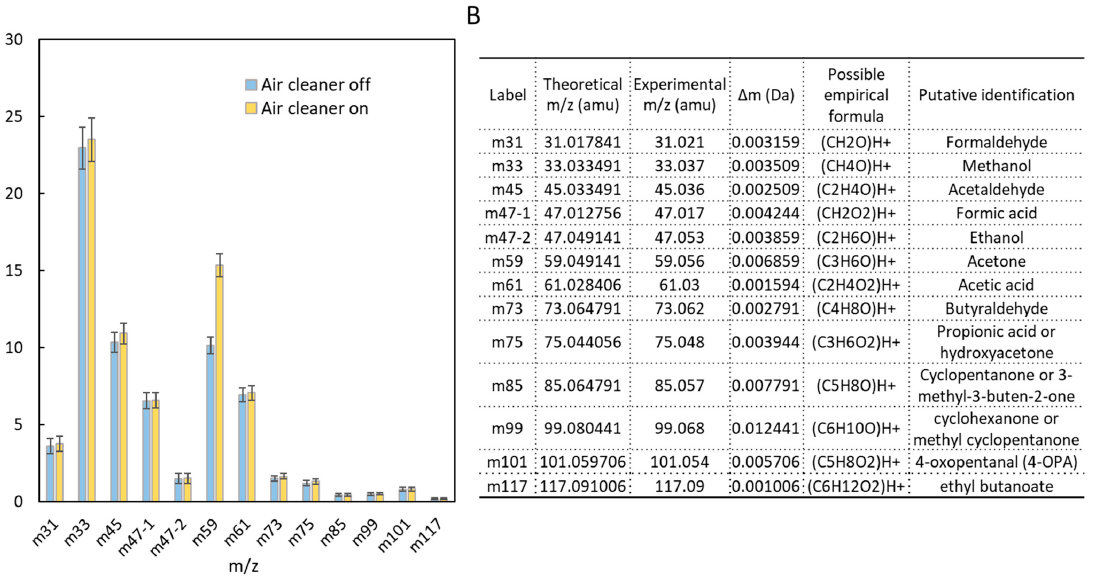
Figure 13. Panel ( A ): Mean concentration of several VOCs of interest as potential byproducts of limonene oxidation during the perturbation test presented in Figure 12 (injection of limonene) when the air cleaner was off (blue bars) and when the air cleaner was on (yellow bars). Error bars correspond to the standard deviation over each period of the perturbation test. The 10 first and last minutes of each period (on or off) are excluded for the calculation to avoid the uncertainty due to the researcher entering and exiting the space to turn the device off or on. Panel ( B ): Table of putative identification based on the exact mass measured by the PTR-TOF-MS.